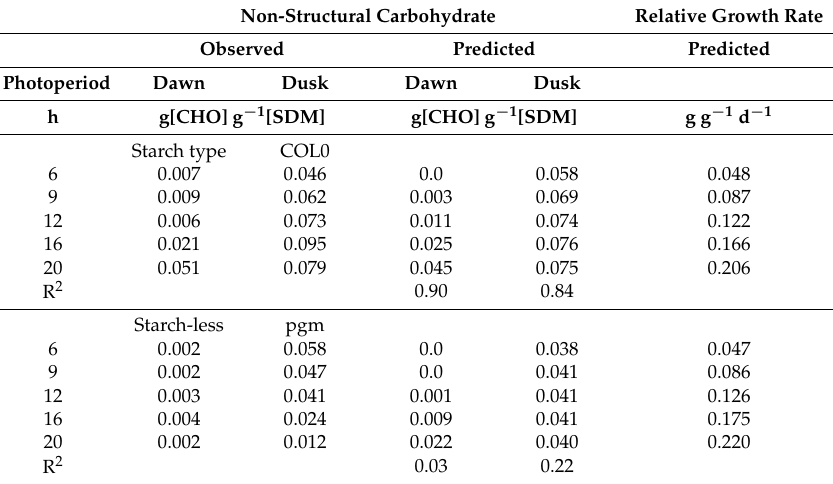
Table 2. Effect of photoperiod on non-structural carbohydrate available in starch type, COL0 , and starch-less, pgm , mutants of Arabidopsis. Observations are from Gibon et al. [31] and predictions are from the dynamic model, including relative growth rate. R 2 is the correlation between observed and predicted